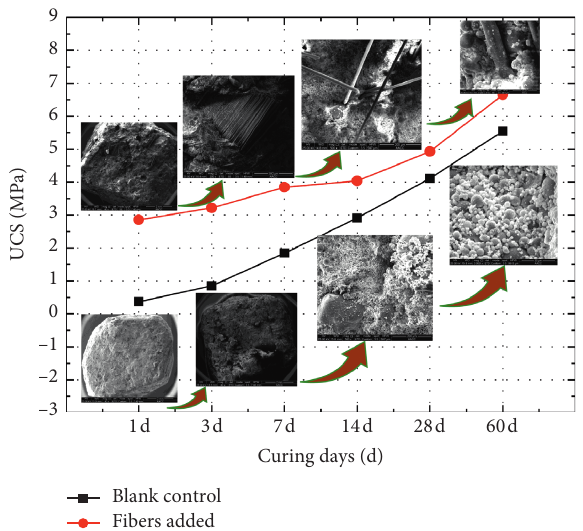
Figure 15: Correlation between macroscopic and microscopic properties of SCPB specimens.